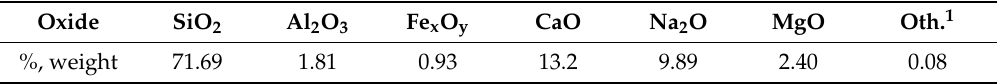
Figure 3. PG morphology. Table 2. PG oxide chemical